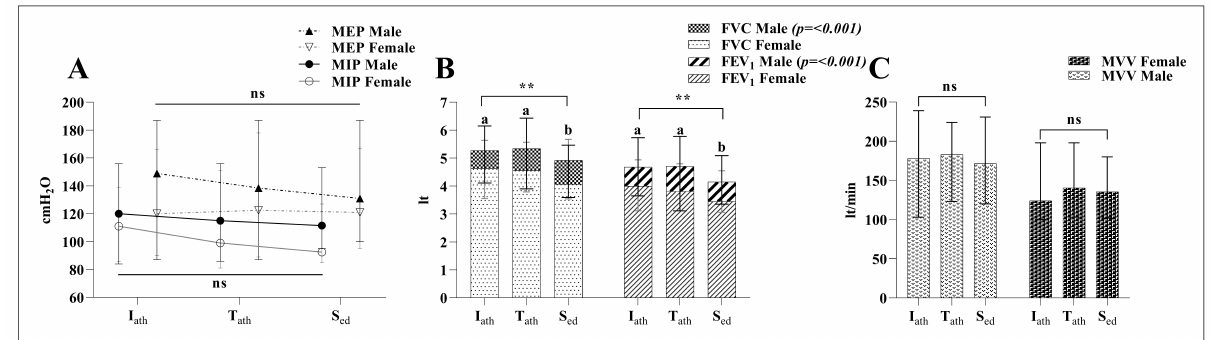
Fig. 3. Respiratory muscle strength and pulmonary functions of male [I ath ( n =82) ; T ath ( n =84) ; S ed ( n =20) ] and female [I ath ( n =15) ; T ath ( n =50) ; S ed ( n =20) ] between groups. Data were expressed as median (min–max). (A) Respiratory muscle strength. (B,C) Pulmonary functions. a,b No significant differences between groups that share the same letter. ** p < 0.001; ns, non-significant; I ath , Individual athletes; T ath , Team athletes; S ed , Sedentary; MIP, Maximal inspiratory pressure; MEP, Maximal expiratory pressure; FVC, Forced vital capacity; FEV 1 , Forced vital capacity at 1 second; MVV, Maximal voluntary